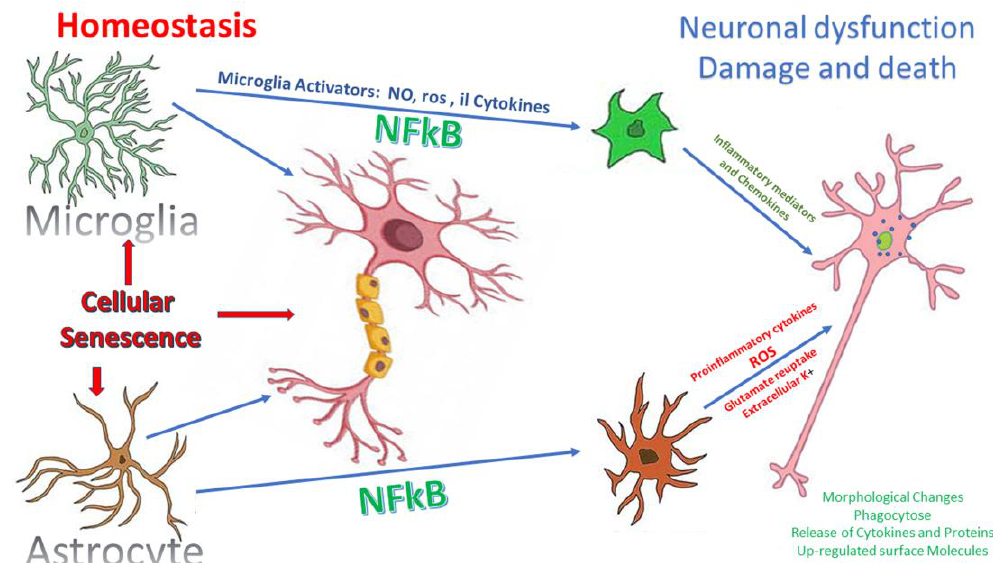
Figure 3. Under physiological conditions, microglia maintain the synapses and their plasticity but signaling pathways, such as NF-κB, can be activated in various ways. The activated microglia and reactive astrocytes produce ROS and neurotoxic molecules which can lead to neuronal death. In addition, the senescence of microglia and astrocytes causes inflammation and a loss of trophic support. The senescence of the oligodendrocytes reduces the myelin and influences the nerve transmission, while the senescence of the endothelial cells influences the barrier functionality. Reactive astrogliosis with up-regulation of pro-inflammatory cytokine production, excitotoxicity of glutamate and hyperexcitability of neurons may also